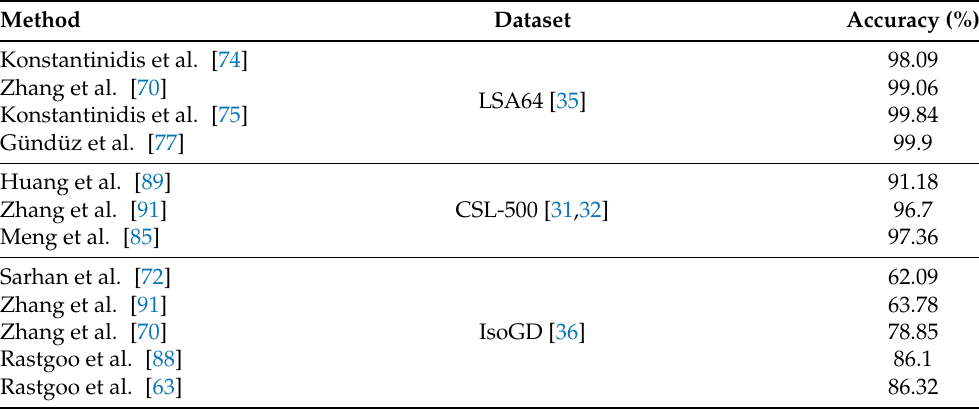
Table 3. Performance of ISLR methods on well-known datasets. The best performance for each dataset appears in